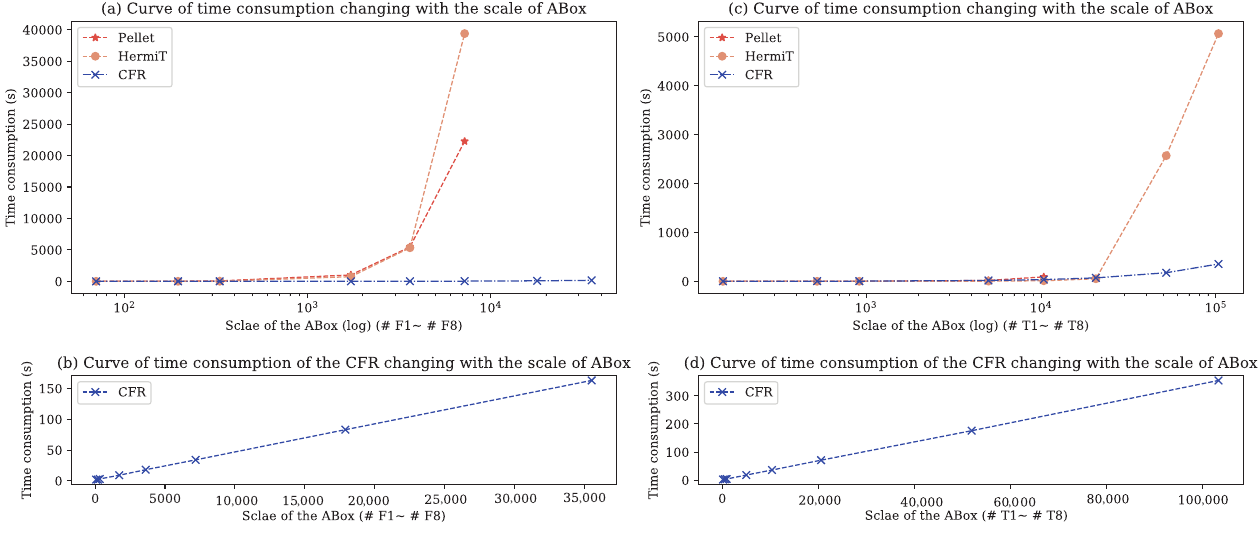
Figure 4. Curve of time consumption of Pellet, HermiT and the CFR changing with the scale of